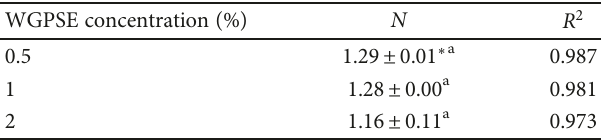
Table 3: E ff ect of the concentration of wheat-gluten proteins soluble in ethanol (WGPSE) on the fl ow index ( n ) calculated by power law and Pearson correlation coe ffi cient